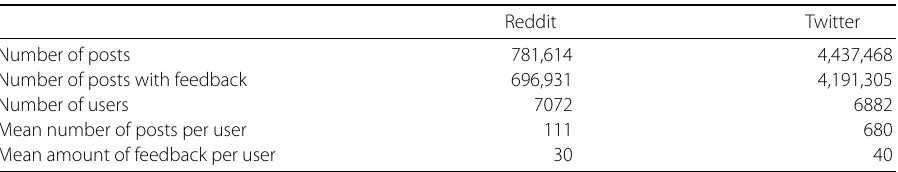
Table 1 Statistics of the two online communities analyzed in this study